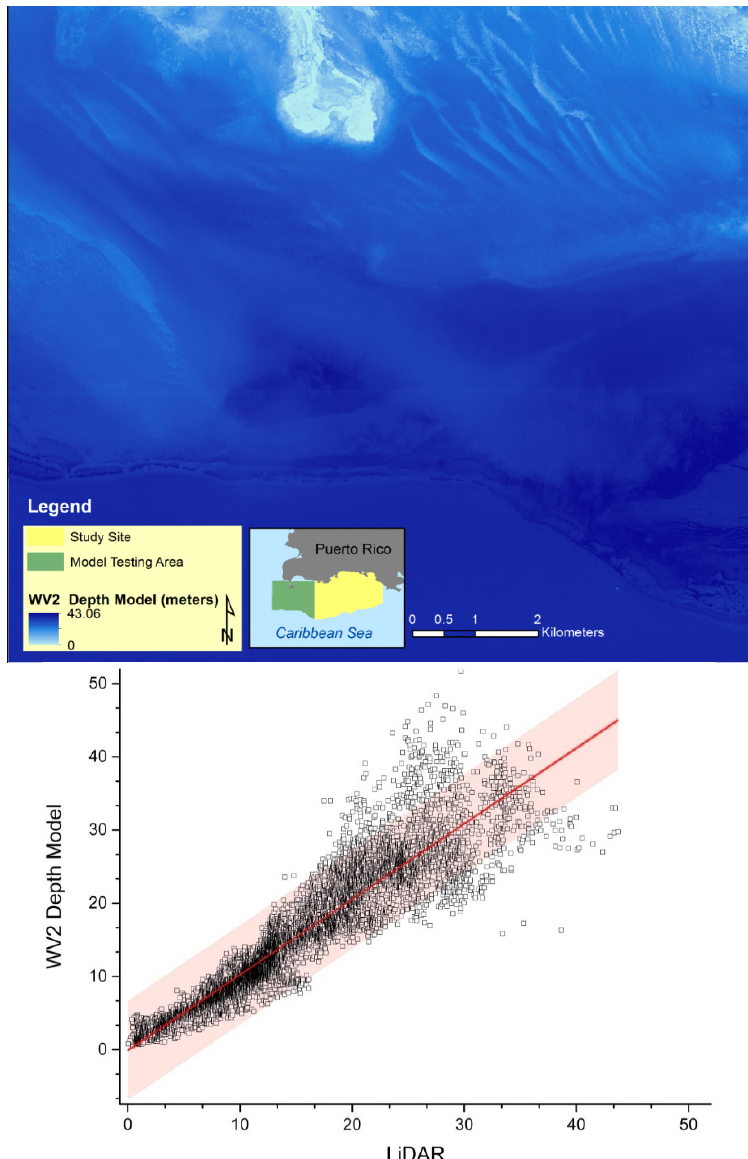
Figure 10. ( Top ) Depth estimation based on WV2 depth model for validation site within the WV2 image off southwestern Puerto Rico. ( Bottom ) Depth values (in meters) for WV2 depth model and LiDAR depths with 95% confidence and prediction bands. Note values dispersion after 20 ‐ m depth.